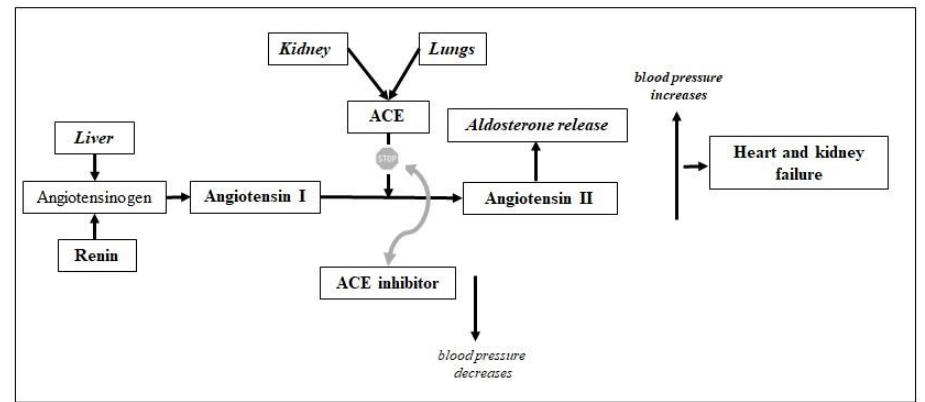
Figure 4. Brief description of the mechanism of action of ACE and its inhibitors according to Iwaniak et al. [26].